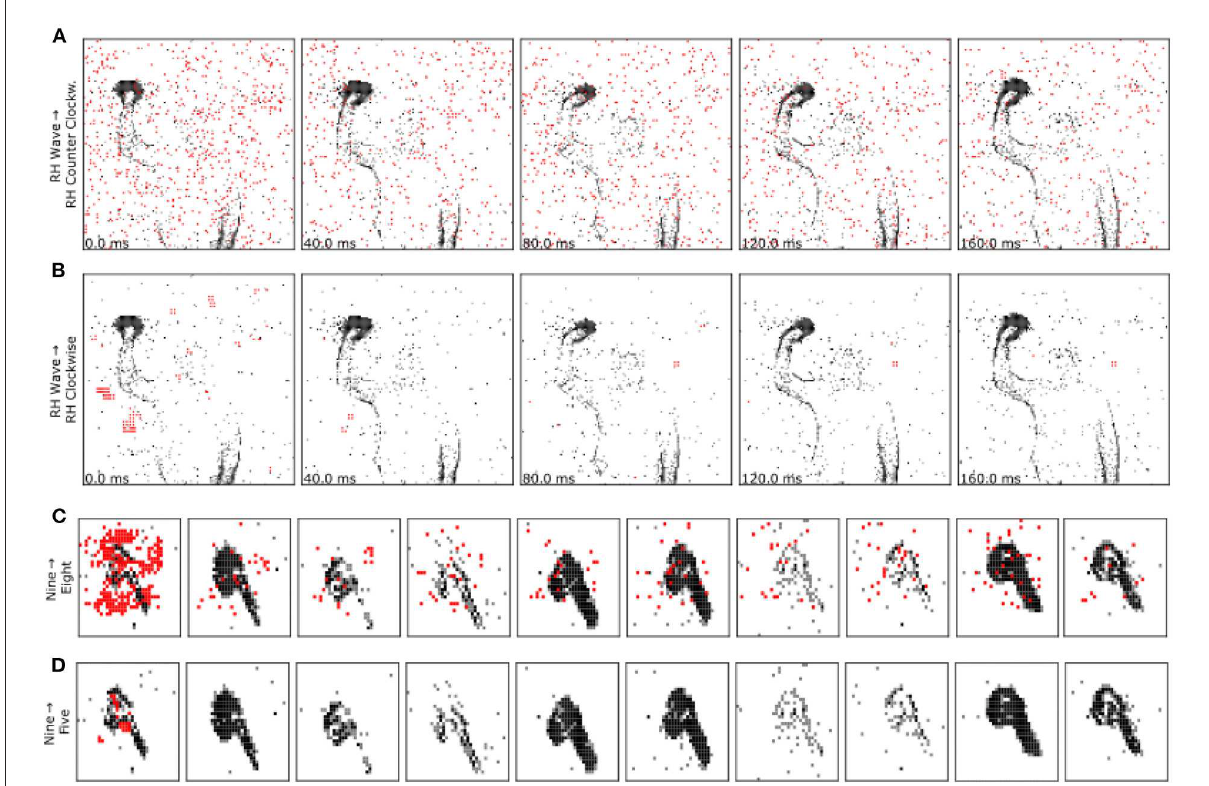
FIGURE2 Our method (B, D) significantly reduces the magnitude of the perturbations introduced by the adversary. The runner-up method proposed in Liang et al. (2020) (A, C) adds visibly more events and is thus less stealthy.